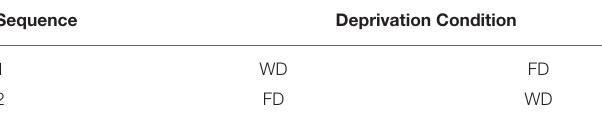
FIGURE 7 | Representation with linear projection by principal component analysis of multidimensional data of all sessions and subjects for six dimensions: coincidence index , divergence , mean distance to the water dispenser , entropy , traveled distance , and maximum velocity with time based-schedule, FT and VT, as a target feature. The direction of each vector points out the direction to increasing values for a given dimension. TABLE 1 | Sequence of deprivation conditions for each